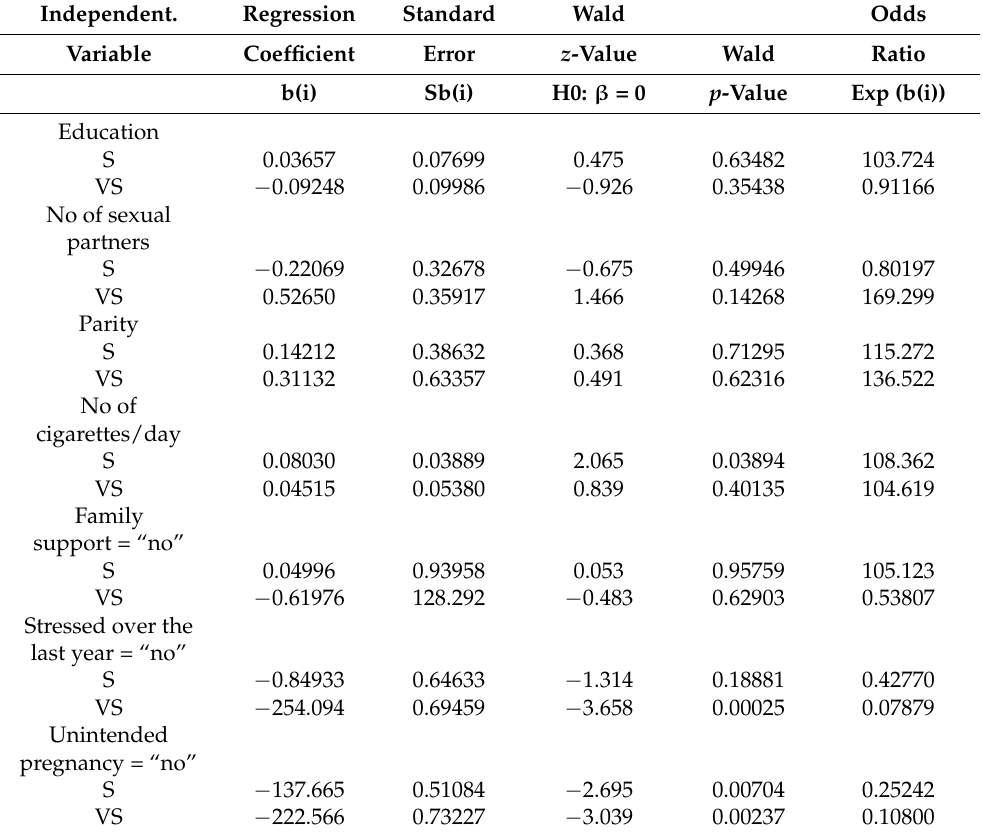
Table 3. Multinomial logistic regression and coefficient significance